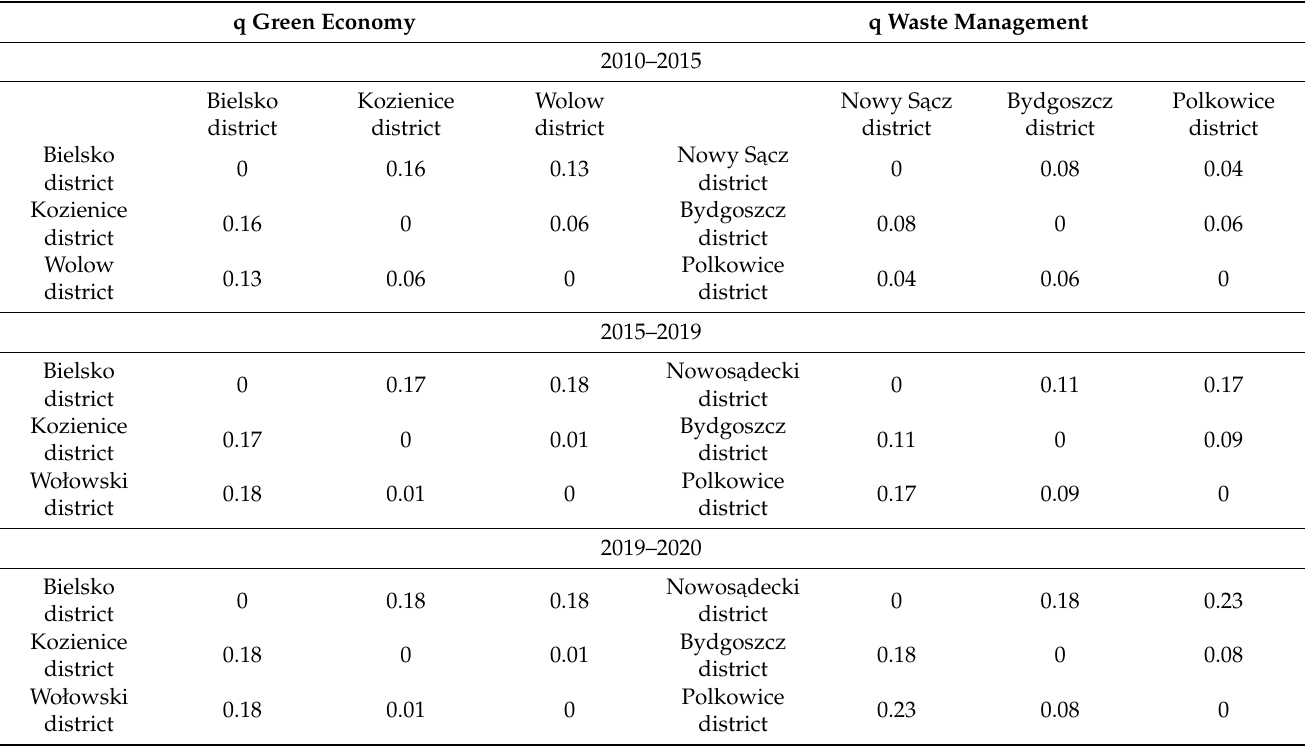
Table 5. Distance between the best and the weakest unit (according to the similarity matrix) for the synthetic measure waste management and green economy of districts.